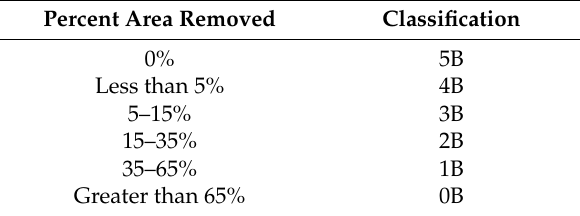
Table 2. Classification of adhesion test results.